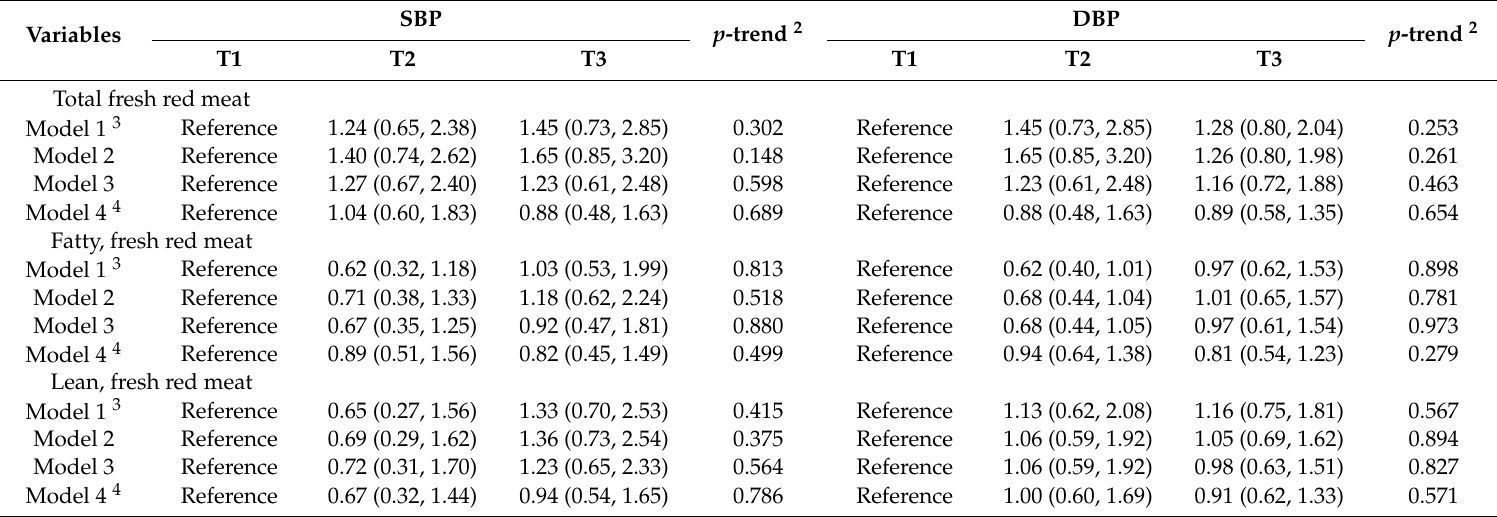
Table 2. Regression coe ffi cients (95% CI) of SBP and DBP according to level of intake of total fresh red meat and subtypes among male Chinese, CHNS 1 .